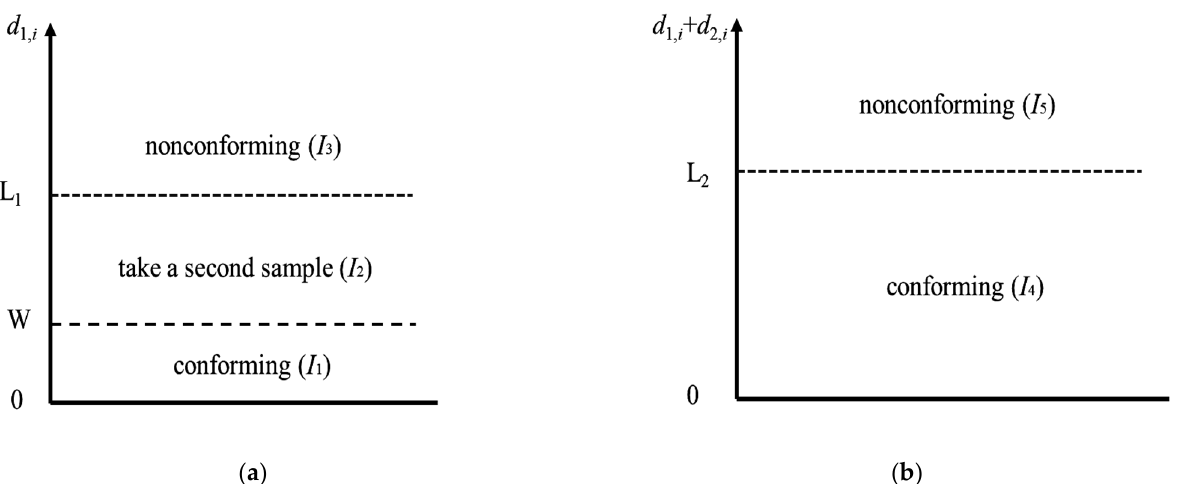
Figure 1. Graphical view at ( a ) first stage and ( b ) second stage of the DS sub-chart’s operation.